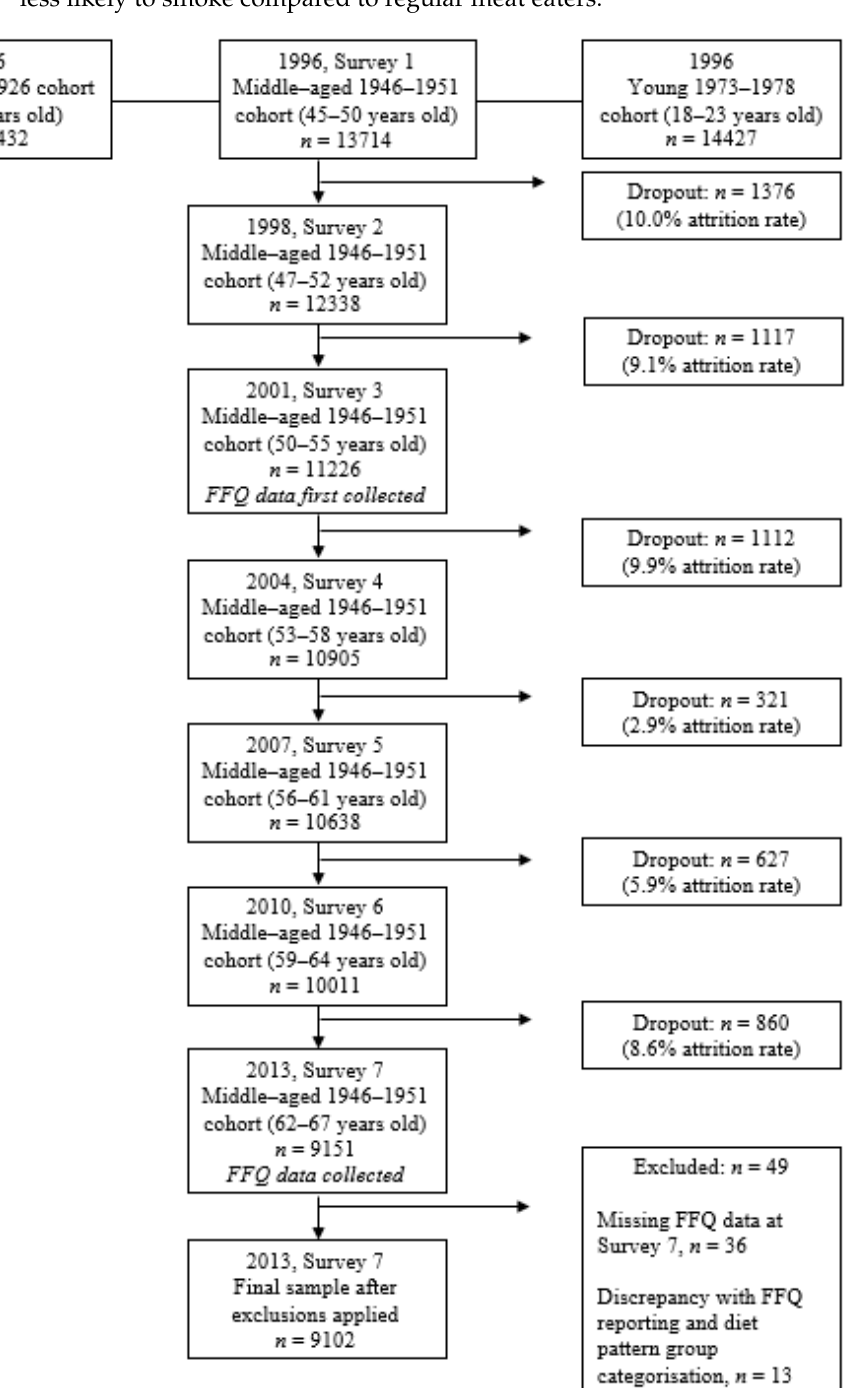
Figure 1. Australian Longitudinal Study of Women’s Health: flowchart of the 1946–51 cohort sub- jects.